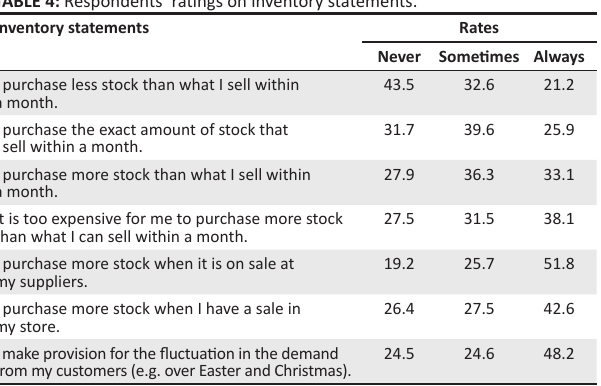
TABLE 4: Respondents’ ratings on inventory statements.